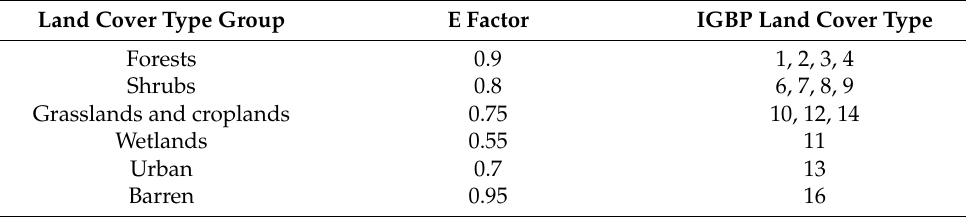
Table 2. List of E factors related to land cover type. Land Cover Type